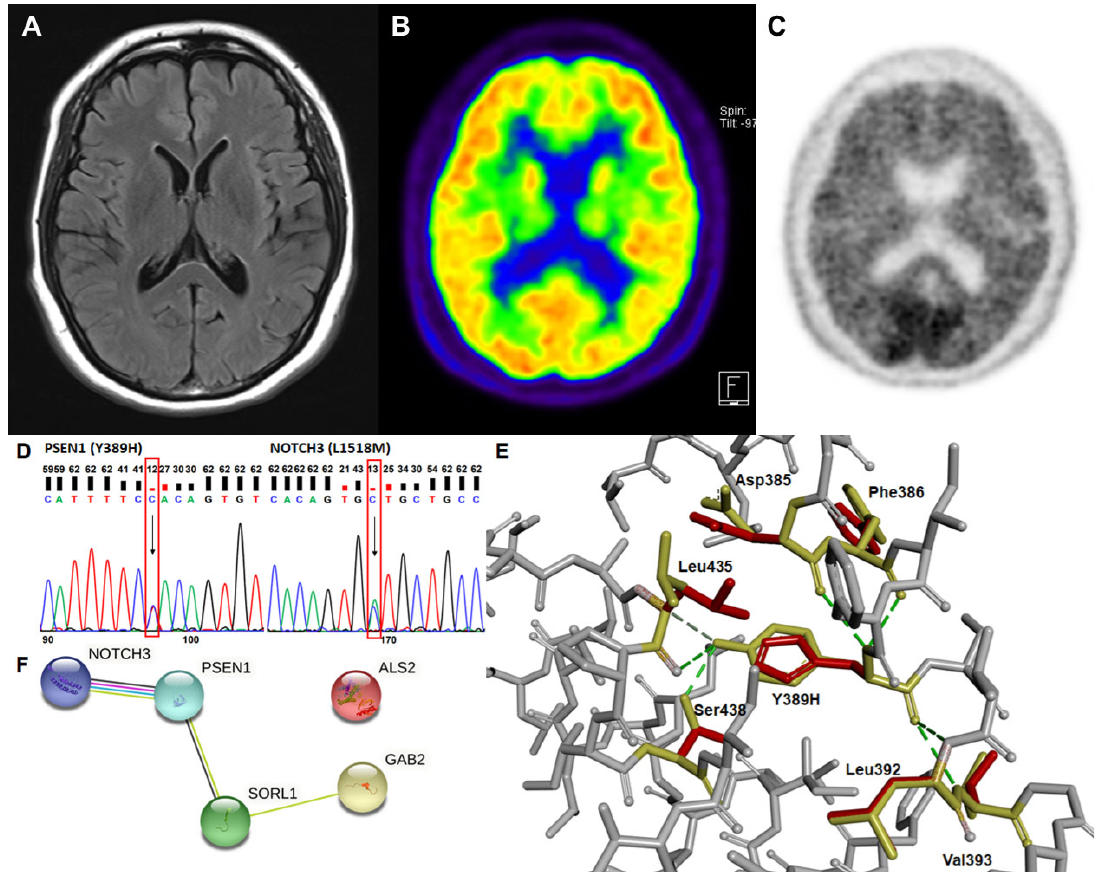
Figure 1. Brain images, prediction of gene interactions, and the alterations in the intermolecular interactions from the genetic analysis of a patient are presented. ( A ) The axial brain fluid-attenuated inversion recovery magnetic resonance image shows minimal cortical atrophy. ( B ) The axial 18F-fluorodeoxyglucose positron emission tomography image reveals mild hypometabolism in the bilateral parietotemporal areas. ( C ) The 18F-florbetaben positron emission tomography image shows positive findings. ( D ) Sanger sequencing of PSEN1 and NOTCH3 variant. Each heterozygous variant is indicated by a black arrow and a red box. ( E ) The structural changes due to the absence of hydrogen bonds of His389 with Leu435 and Ser438 amino acids in mutant presenilin-1 protein were predicted. The original amino acids and their positions are presented in yellow, while mutant His389 and the altered position of the related amino acids are in red. ( F ) Possible interaction among genes for which rare variants were found in a